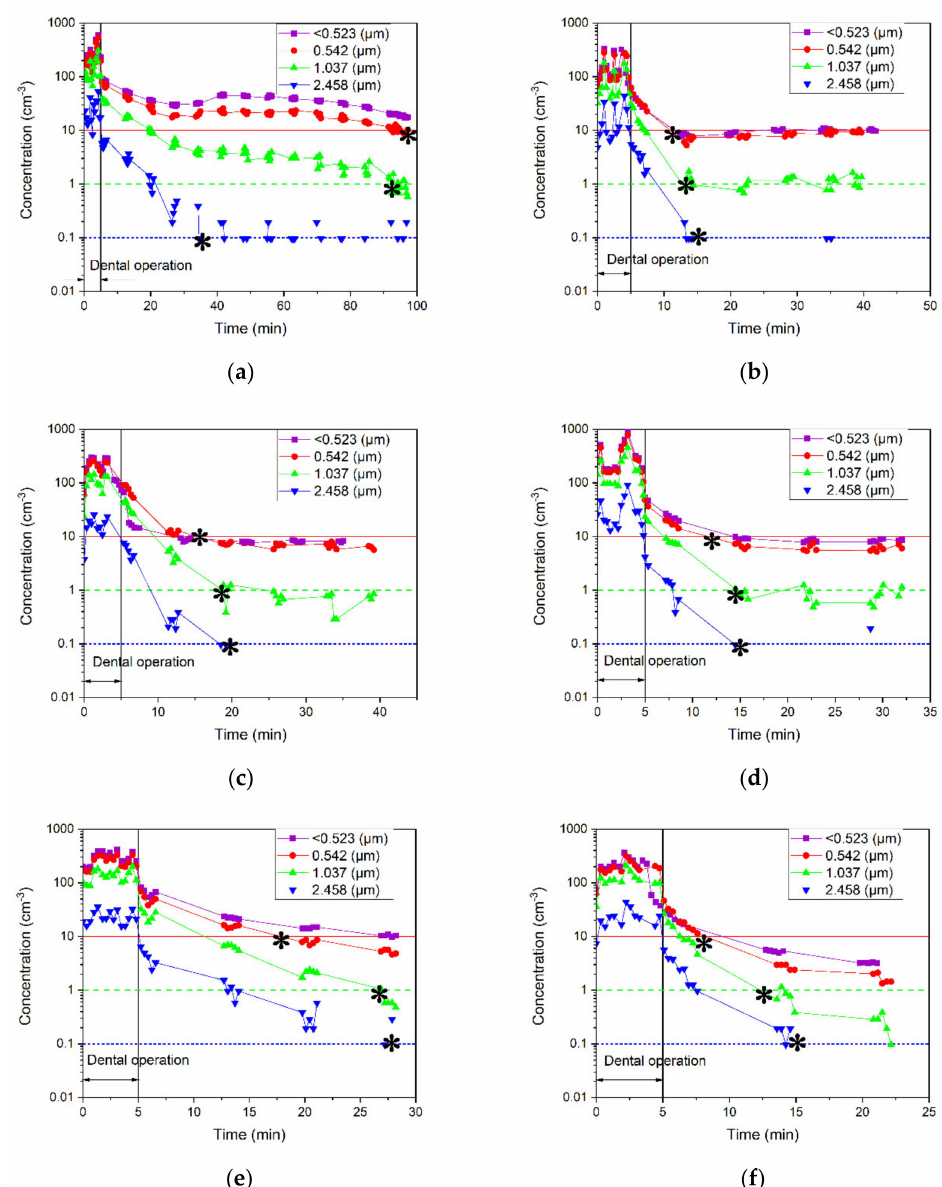
Figure 5. Number concentrations of sub-0.5-, 0.5-, 1-, and 2.5- µ m particles measured in the generation zone for ( a – d ) closed- door cases with ( a ) air purifier off, ( b ) low-speed air purifier turned on after particle generation, ( c ) high-speed air purifier turned on after particle generation, ( d ) and high-speed air purifier running from the beginning of particle generation; and ( e , f ) open-door cases with ( e ) air purifier off and ( f ) high-speed air purifier running from the beginning of particle generation. The background concentration is shown with the red horizontal line for <0.5- and 0.5- µ m particles, green dash line for 1- µ m particles, and blue dotted line for 2.5- µ m particles. The removal time for different particle sizes is marked with